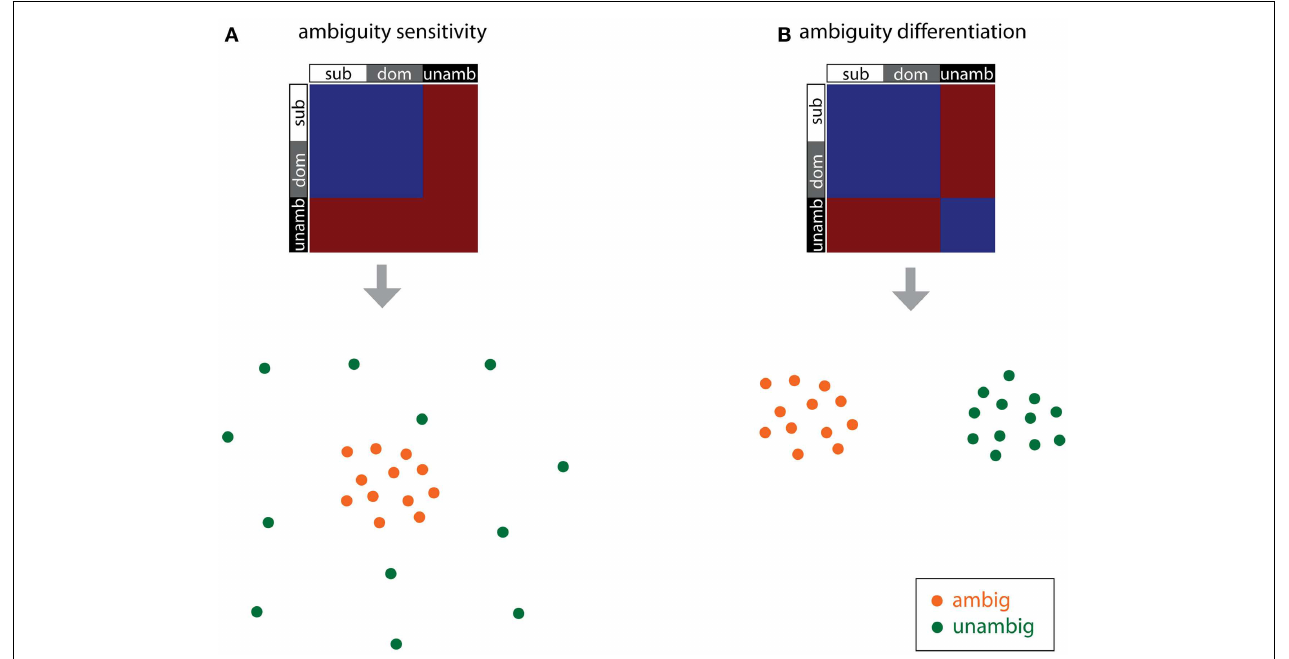
items and so unambiguous items have uncorrelated activation patterns (dissimilar to each other and also dissimilar to the ambiguous items). (B) The ambiguity differentiation RDM tests the hypothesis that ambiguous items and unambiguous items give rise to different distinct patterns of activation: ambiguous items are similar to each other, unambiguous items are similar to each other, and ambiguous and unambiguous items